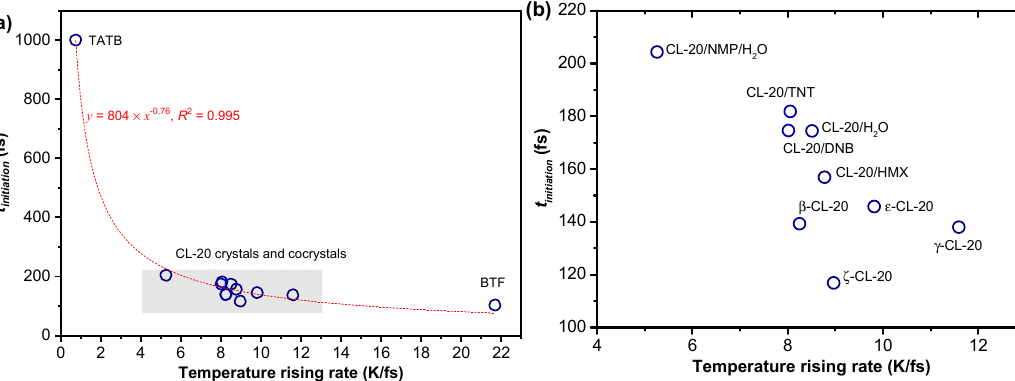
Figure 6. ( a ) Correlation between the shock sensitivity and the temperature rising rate under shock; ( b ) is an enlarged plot in a focused range, as marked by gray in plot ( a ). ( b ) is an enlarged plot in a focused range, as marked by gray in plot ( a